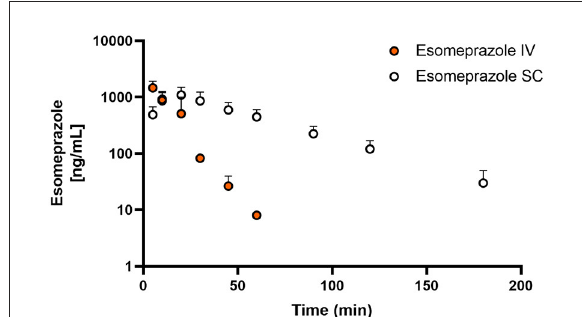
FIGURE1 Mean plasma esomeprazole concentration (logarithmic scale) vs. time (hr) profiles for adult goats ( n = 5) following intravenous (IV) single dose administration of 1.0 mg/kg of esomeprazole (orange) or subcutaneous (SC) single dose administration of 2.0 mg/kg of esomeprazole (white). Mean is represented by a circle with upward standard error bars.